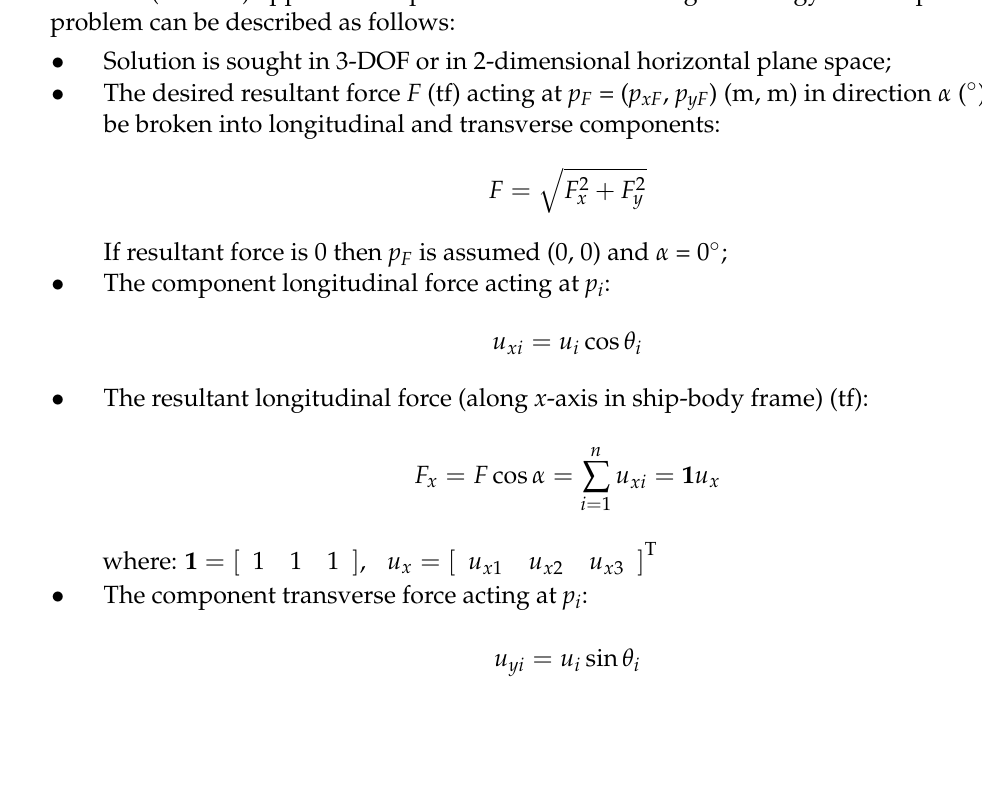
Figure 2. Thrust forces acting on a vessel and the resultant